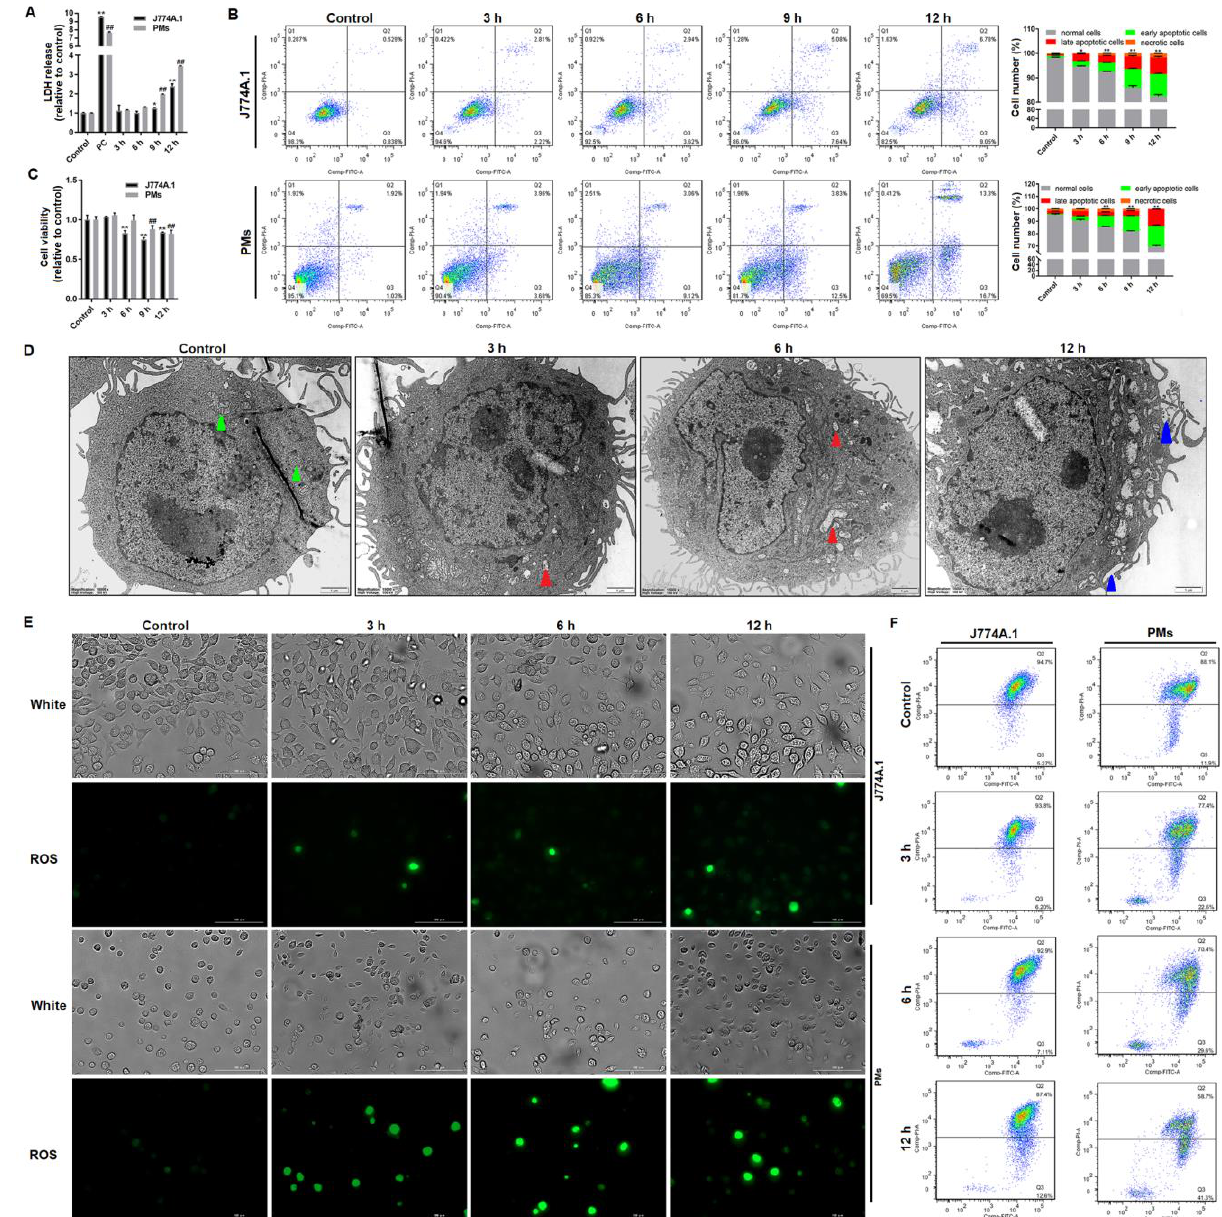
Figure 1. The negative effects of Giardia treatment on macrophages. J774A.1 cells or PMs were treated with trophozoites at a ratio of 10 parasites/cell for the indicated time periods, and then ( A ) LDH release in the culture supernatant was measured. ( B ) Annexin V-positive cells were analyzed with flow cytometry. Normal cells are in the lower left quadrant, necrotic cells in the upper left quadrant, early apoptotic cells in the lower right quadrant, and late apoptotic cells in the upper right quadrant. ( C ) Macrophage viability was examined by CCK-8 assay. ( D ) Damage of mitochondria and dis- ruption of cell membrane integrity in PMs were observed by TEM (scale bar = 1 μm). Green arrows indicate normal mi- tochondria, red arrows indicate damaged mitochondria, and blue arrows indicate damaged plasma membrane. ( E ) ROS generation in macrophages was measured by fluorescence microscopy (scale bar = 100 μm). ( F ) The changes of MMP among groups were detected with flow cytometry. The horizontal axis gives the green fluorescence intensity, and vertical axis gives the red fluorescence intensity. All experiments were repeated at least three times. ( A – C ) Values are expressed as the mean ± SD (* p < 0.05, ** , ## p < 0.01 as compared to controls). ( D – F ) Representative pictures are shown. 3.2. Giardia-Induced NLRP3/CASP1/GSDMD-Mediated Macrophage Pyroptosis In addition to an increase in LDH release due to plasma membrane rupture, CASP1-mediated activation and the release of IL-1β and IL-18 are also important indi- cators of pyroptosis [37,38]. We found that the mRNA expression of IL-1β and IL-18 was